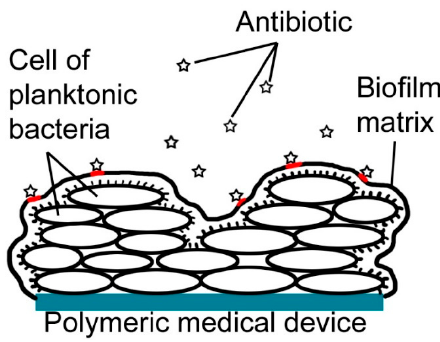
Figure 2. Bacterial resistance of biofilm. Red underlines refer to the area of antibiotic/biofilm matrix contact. Biofilm matrix prevents antibiotics to affects directly the cells of planktonic bacteria. Table 2. Methods of antimicrobial treatment of polymeric medical devices.